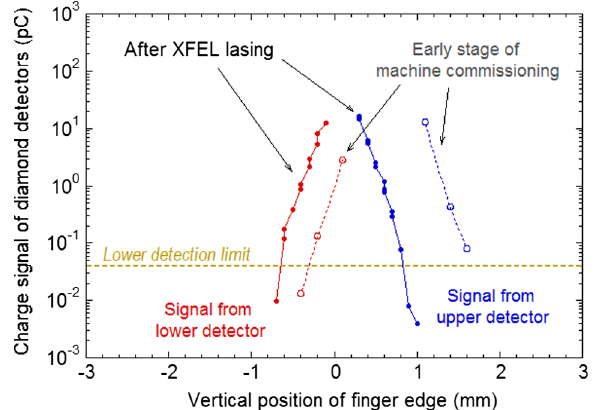
FIG. 21. Effect of rf finger edge position on charge signal of diamond-based detectors. Solid lines were obtained after XFEL lasing. Dashed lines were obtained during the early stage of machine commissioning. The lower detection limit of 2 (cid:1) 10 3 electrons = pulse , which corresponds to 0.04 pC, is indicated. The typical beam size after XFEL lasing is 0.06 mm ( (cid:1) ). The beam size during the early stage of machine commissioning is esti- mated to be much larger than